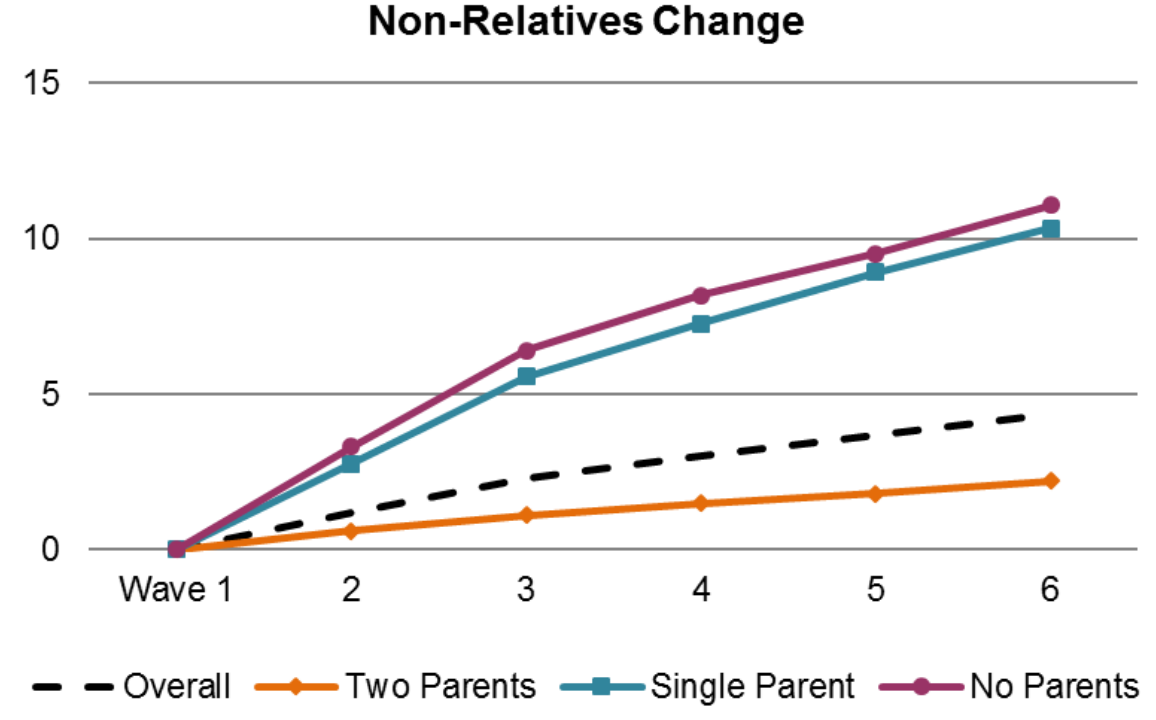
Figure 3: Weighted cumulative percent of children (by family structure) exposed to nonrelatives leaving and joining